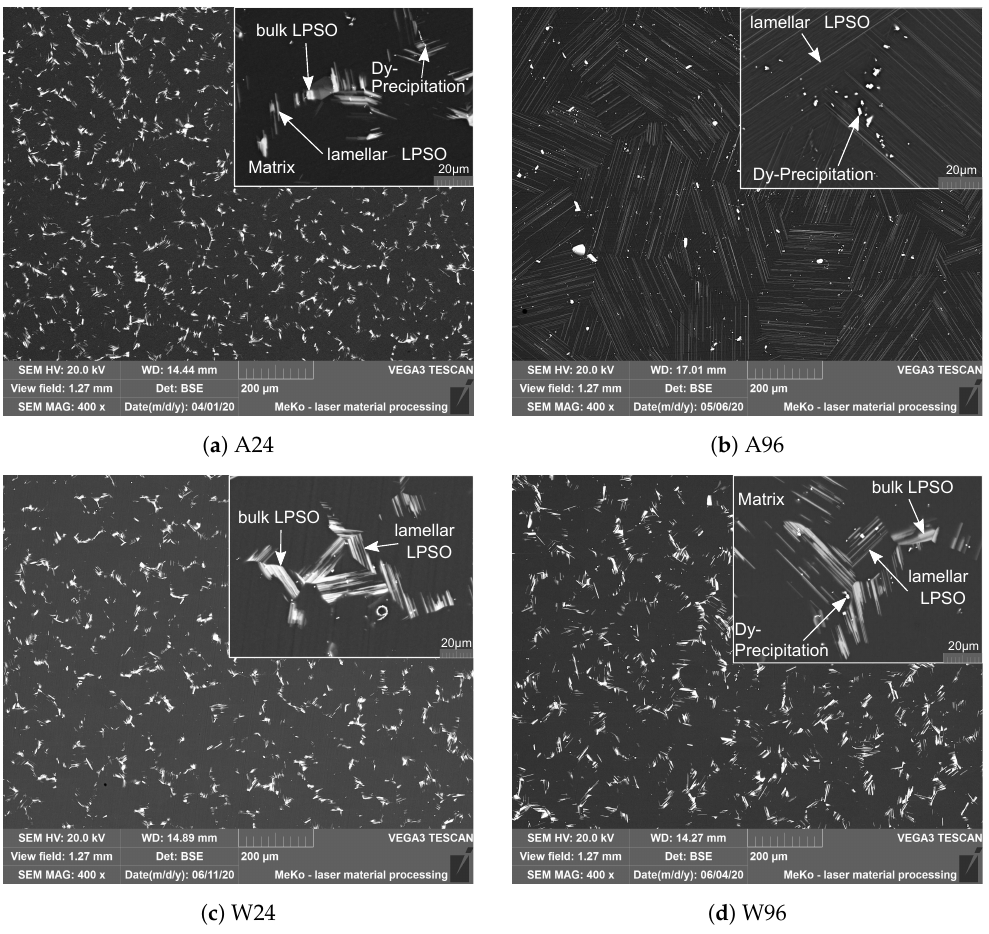
Figure 3. Exemplary SEM images of the phases in air-cooled platelets from sample group ( a ) A24 and ( b ) A96 and water-quenched platelets from sample group ( c ) W24 and ( d ) W96. The platelets are shown in longitudinal section. The small pictures in the top right corner show the platelets at higher magnification. Table 2. Chemical composition of the different phases found on average in air-cooled platelets in wt.% with indication of the standard deviation (n=3).